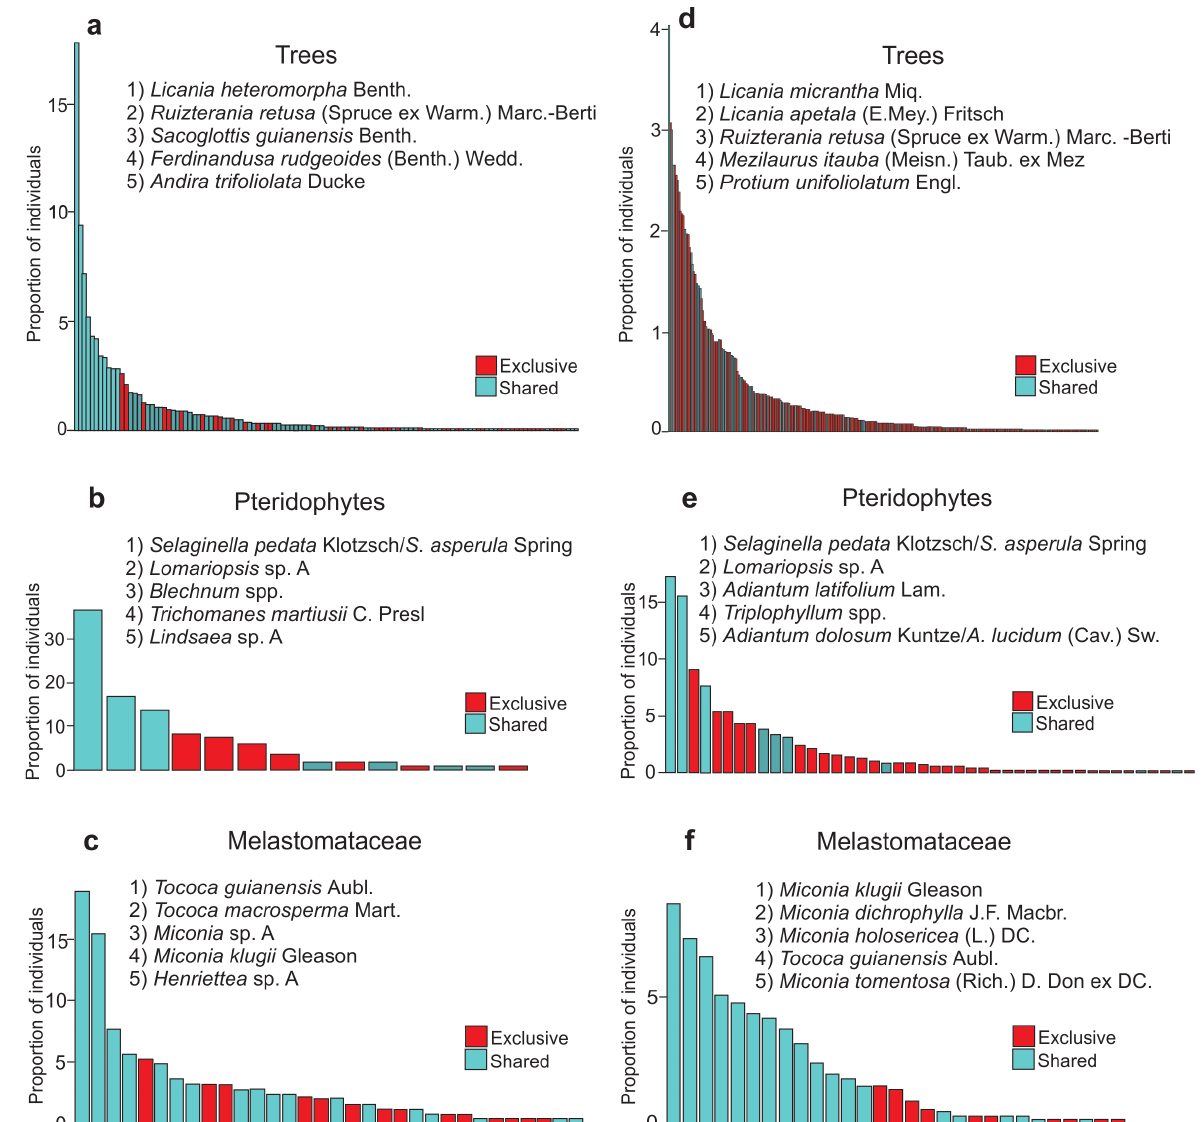
Figure 5 - rank abundance curves of plant species inventoried in the area of Viruá megafan. a-c ) Plots in megafan sediments. d-f ) Plots in basement rocks. Species colored in red occur exclusively in megafan sediments or other substrates, while species colored in blue are shared by at least one plot located in each environment.The names of the species are given for the five most abundant species in each group of plants. (see the colored figure in the online version for color